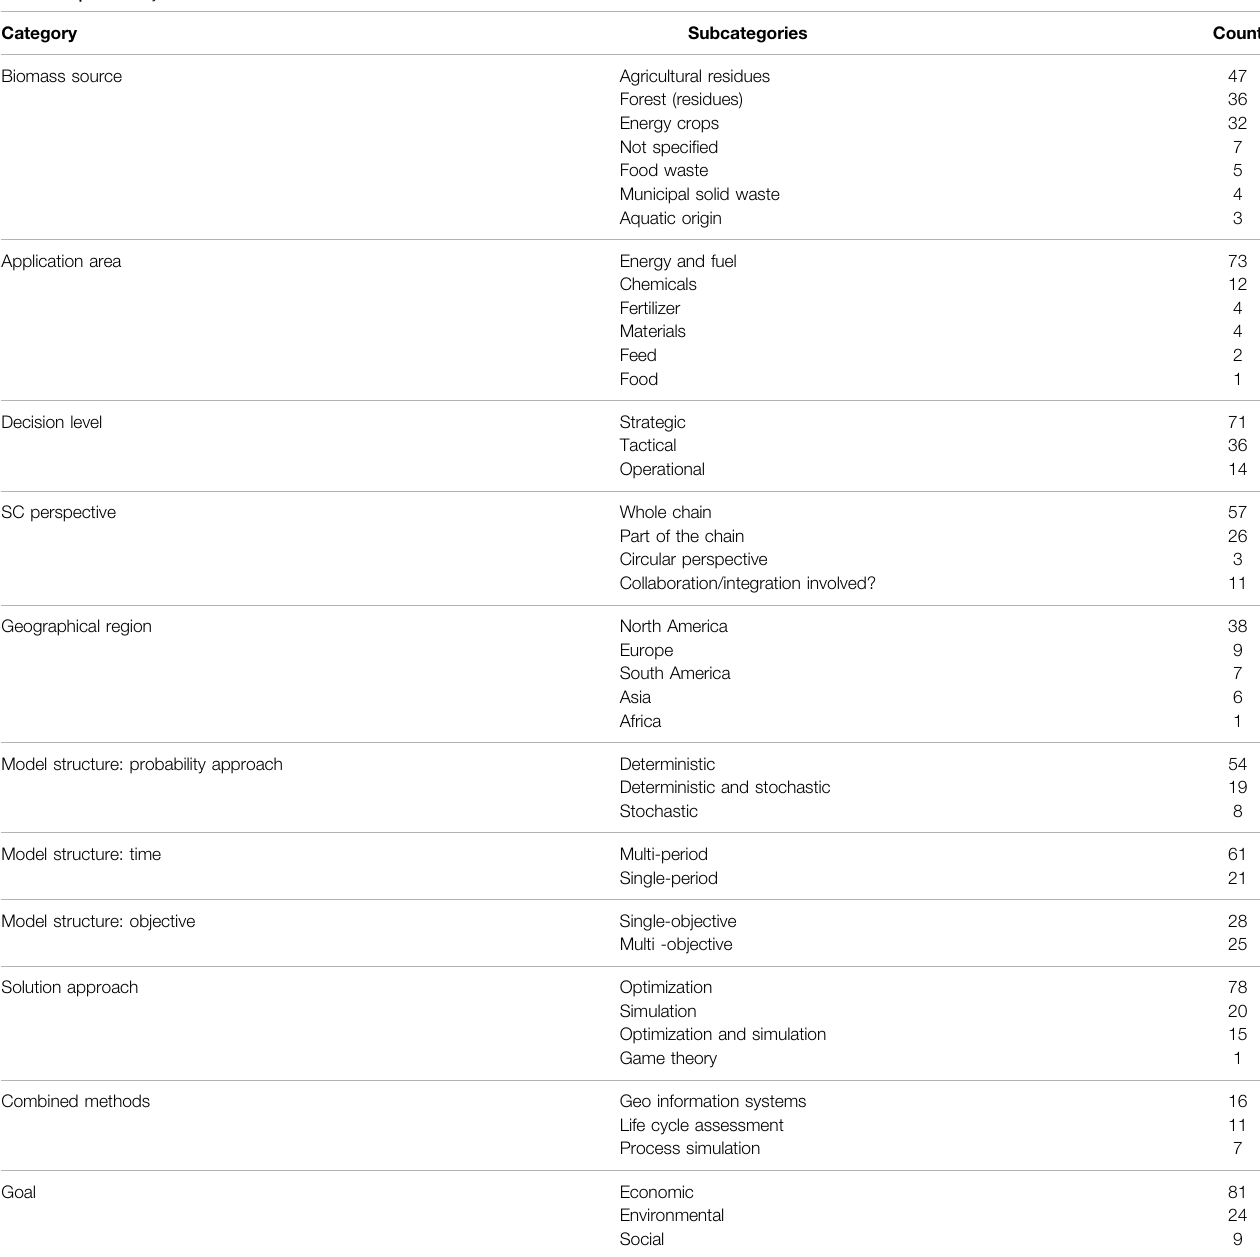
TABLE 4 | Summary of the